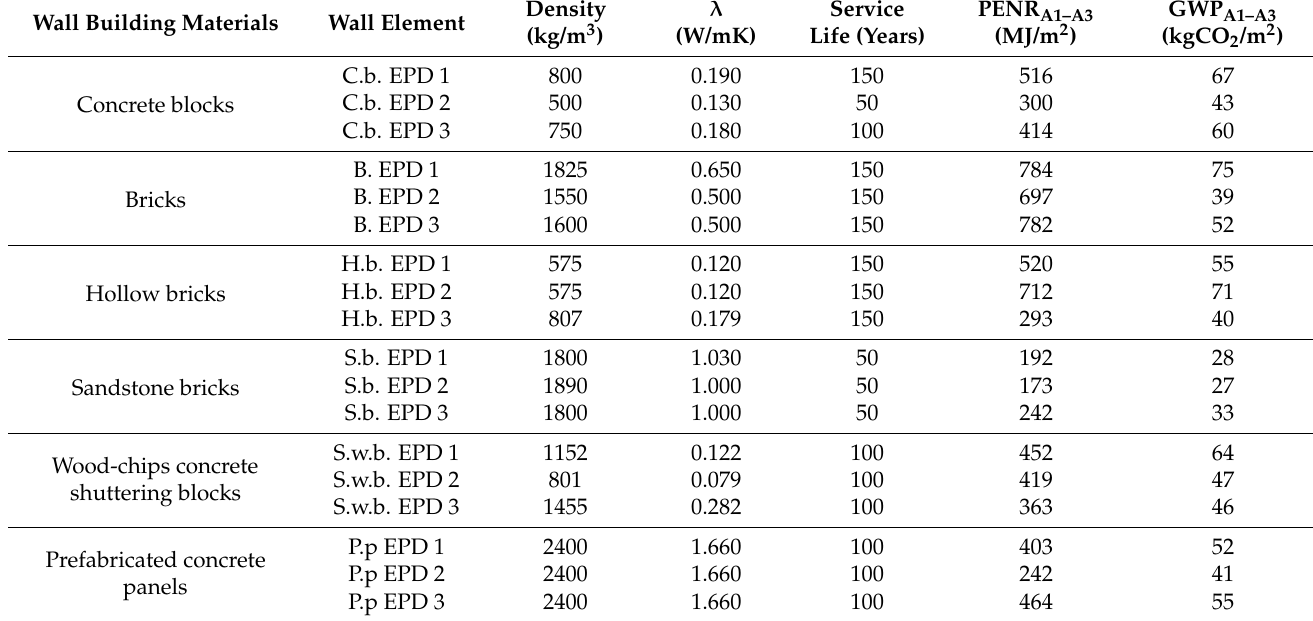
Table 10. Parameters characterizing the masonry layer of the walls considered in this